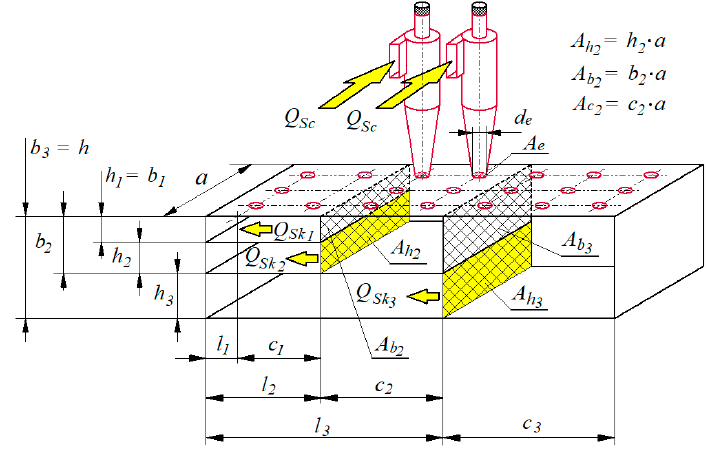
Figure 14. Dust collector segment model with three suction channels.